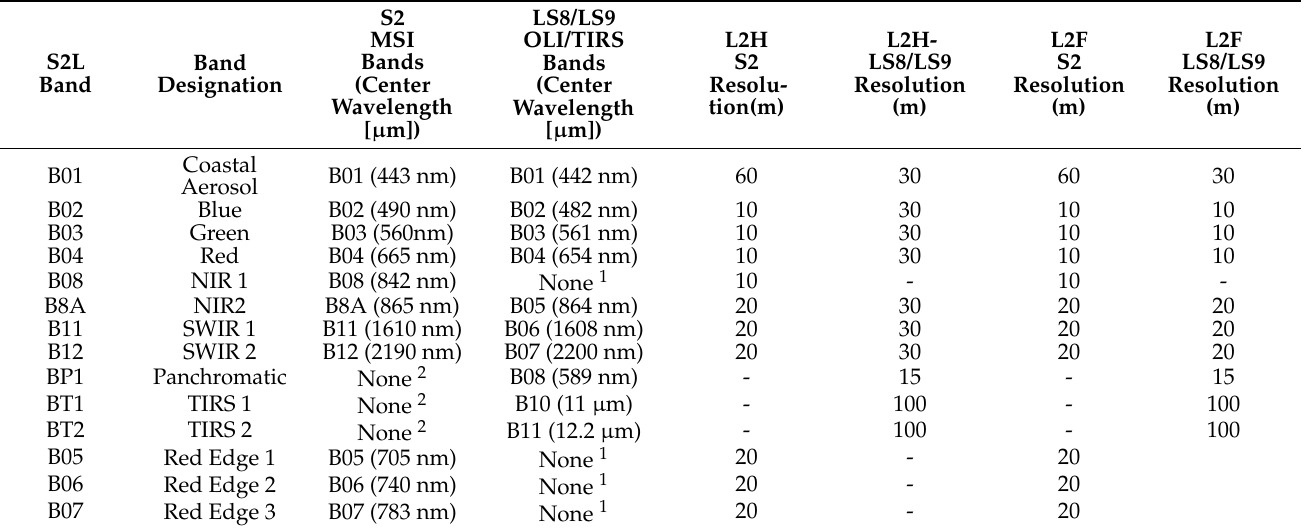
Table 1. Existing image data embedded within the L2H and L2F Sen2Like SAFE products and spatial